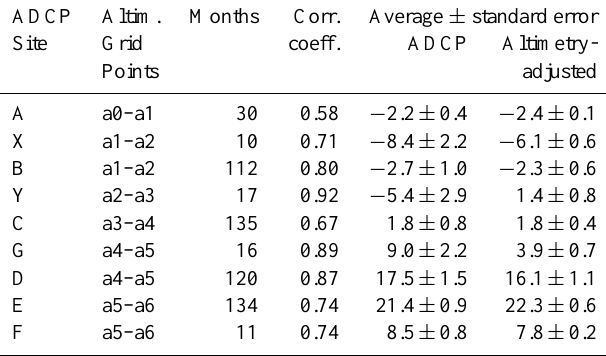
Table 4. Comparison between monthly averaged AW velocity as measured by the ADCPs (see text for details) and sea level change between corresponding altimetry grid points. The fourth column lists the correlation coefficient between them. The last columns list the average ± standard error of the AW velocity (cms − 1 ) based on the ADCP measurements and on the altimetry adjustment, respec- tively. For the ADCP measurements, the average and standard error are calculated for the months with full data coverage. For the al- timetry, the whole period 1995–2009 is used and the altimetry data converted to velocities through linear regression.